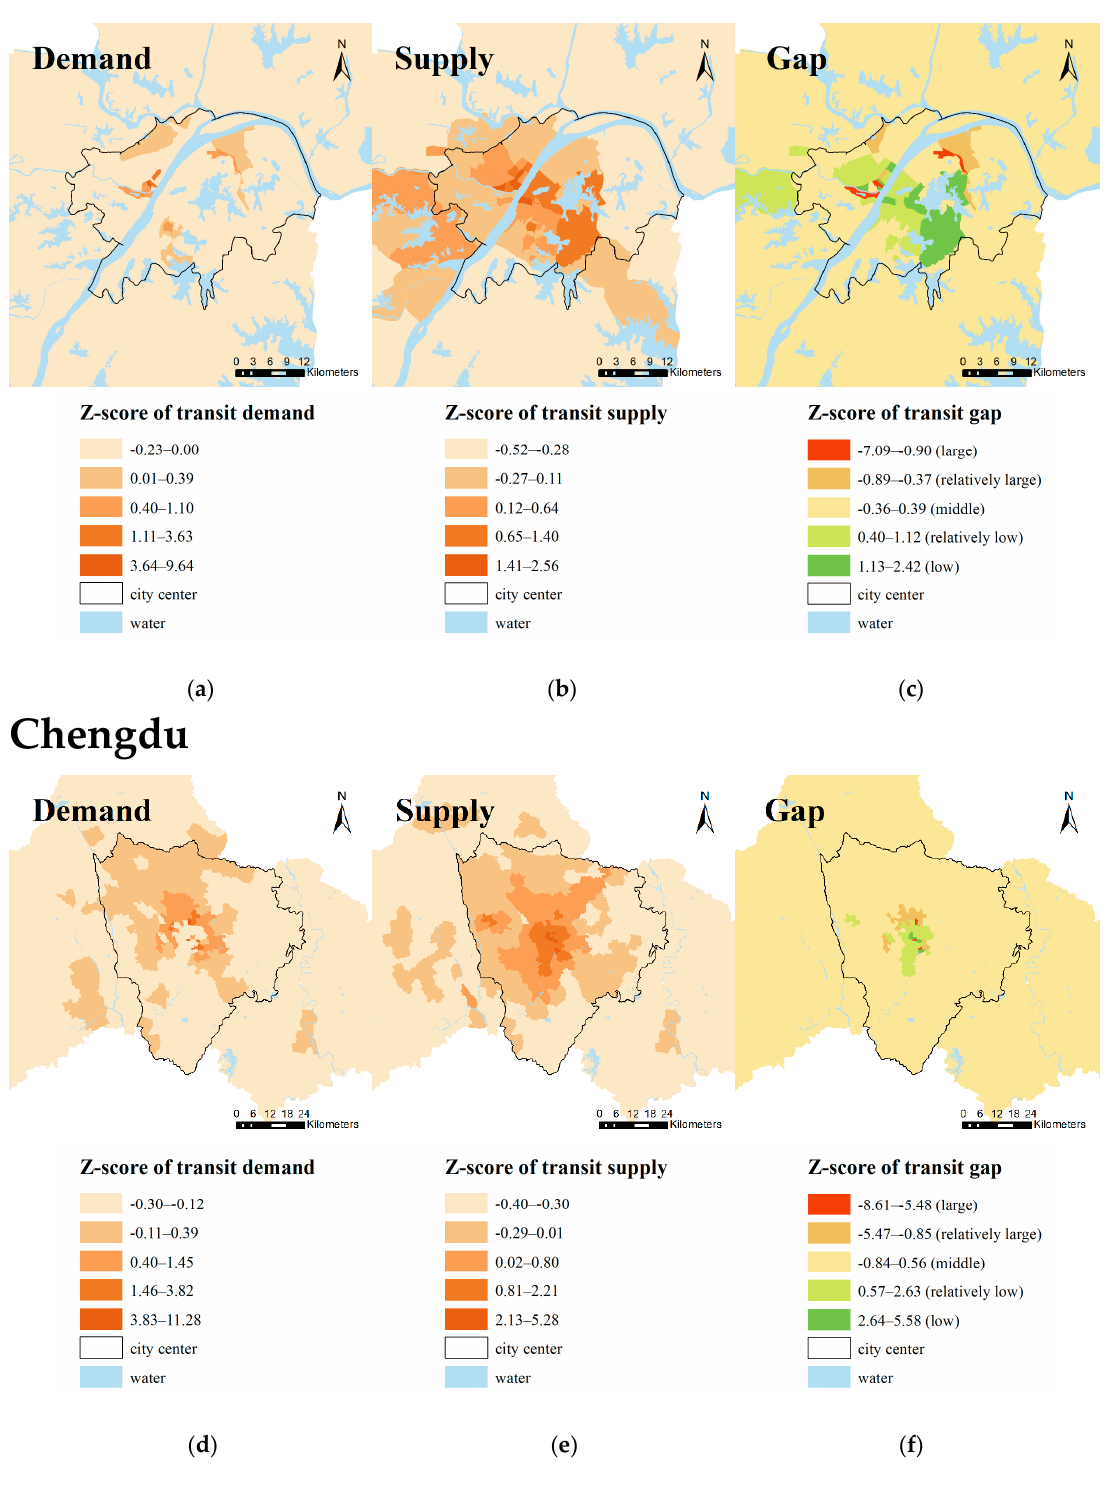
Figure 3. Transit gaps between supplies and demands in Wuhan and Chengdu: ( a ) transit demands in Wuhan; ( b ) transit supplies in Wuhan; ( c ) transit gaps in Wuhan; ( d ) transit demands in Chengdu; ( e ) transit supplies in Chengdu; ( f ) transit gaps in